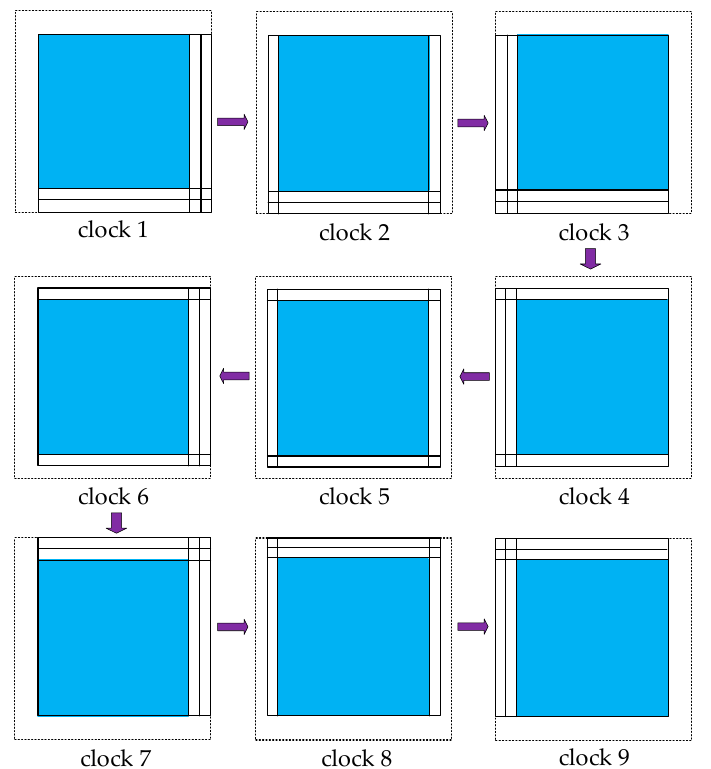
Figure 6. Sliding windows of input registers 2 (IR2) for 3 × 3 convolution, S = 1. Clock 1–9 represent the first to ninth clock cycles, respectively.